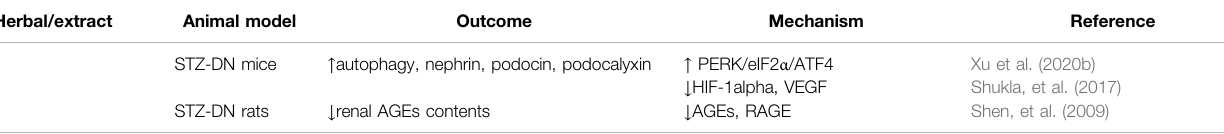
TABLE 1 | ( Continued ) Recent animal studies on Chinese herbal medicines with anti-renal fi brosis function.